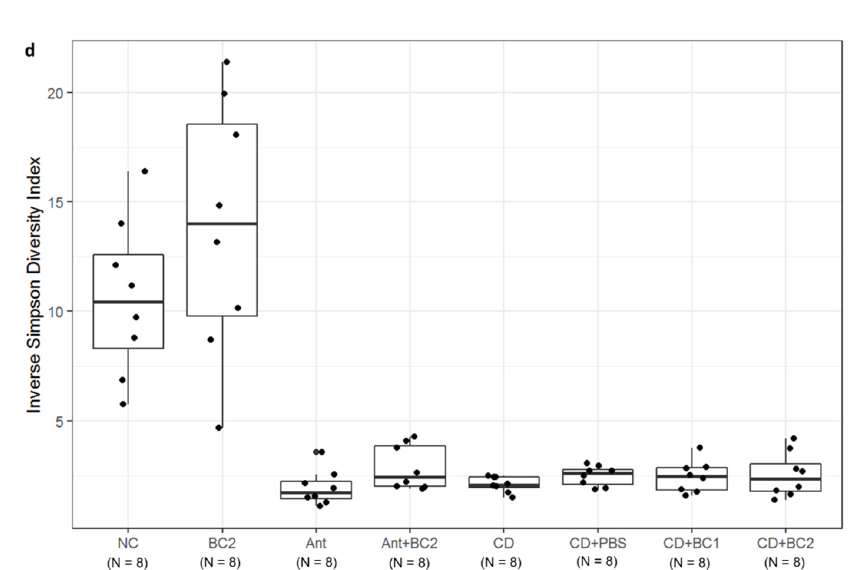
Figure 3. Effect of baicalin supplementation on the abundance of major gut microbiome taxa and microbiome diversity in the antibiotic-treated and C. difficile -challenged mice. ( a ) Relative taxa abundance of OTUs: Fecal samples were collected 2 DPI from the prophylactic BC study. DNA was extracted for microbiome analysis using Illumina MiSeq platform, and the relative abundance of OTUs of major phyla, order, family, and genera was determined. ( b ) Abundance of major bacterial family taxa. Percentage abundances of major families— Lactobacillaceae , Lachnospriaceae , Akkermansia , Peptostreptococcaceae, and Enterobacteriaceae —in the mice treatment groups of the prophylactic BC study. **, * indicates a statistically significant difference ( p < 0.001, p < 0.05, respectively) relative to the untreated challenge group (CD). Error bars represent SEM. ( c ) Bray–Curtis plot: Relationships between treatment groups based on the abundance of species present in each sample were plotted. NMS ordinations were run in R (v 3.3.0) using metaMDS in the vegan (v 2.3-5) package after calculating the stress scree plots to determine the number of axes required to achieve stress below 0.2, plotted using ggplot2 (v 2.1.0). ( d ) Inverse Simpson Plot: Fecal samples were collected 2 DPI of the prophylactic BC study. DNA was extracted for microbiome